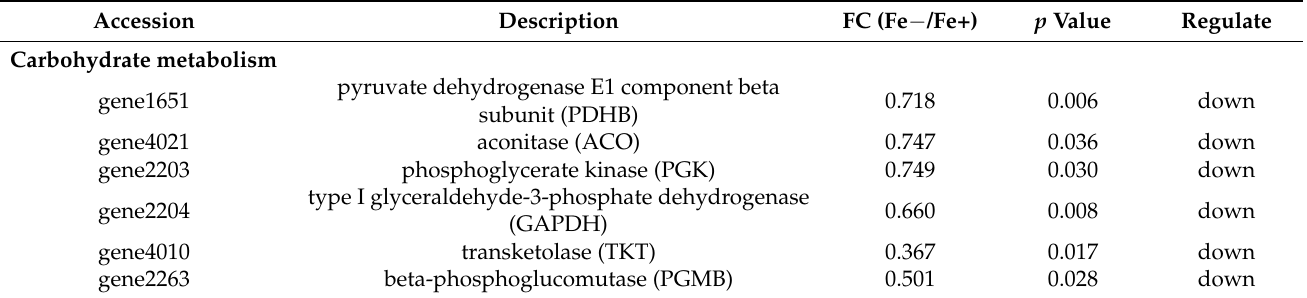
Figure 6. The key DAPs involved in carbohydrate, amino acid, and lipid metabolism. Blue font represents down-regulated DAPs. Different colored lines represent different metabolic pathways. Table 1. The key DAPs in response to Fe limitation.